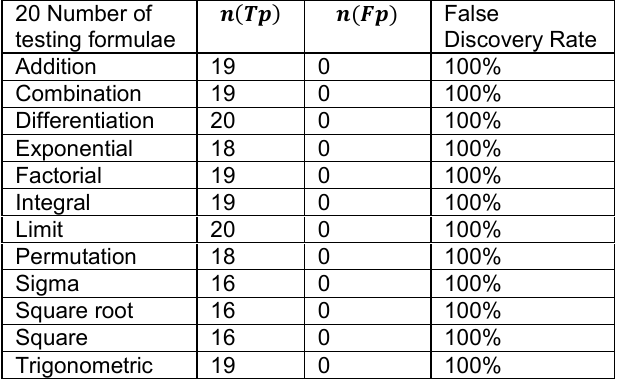
Table 22. The above tabulated value represents overall PPV Measure with Tensorflow from a document of 60 samples.